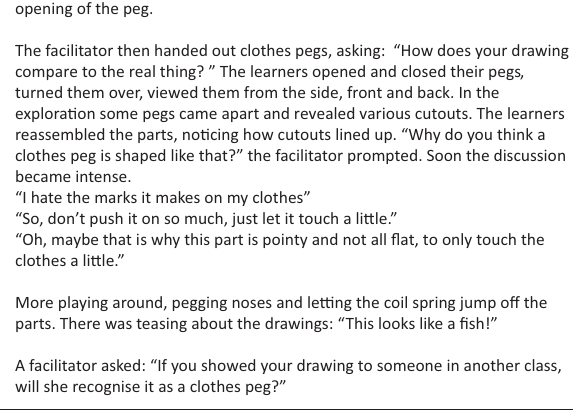
FIGURE 3: Task 1. Vignette: Clothes